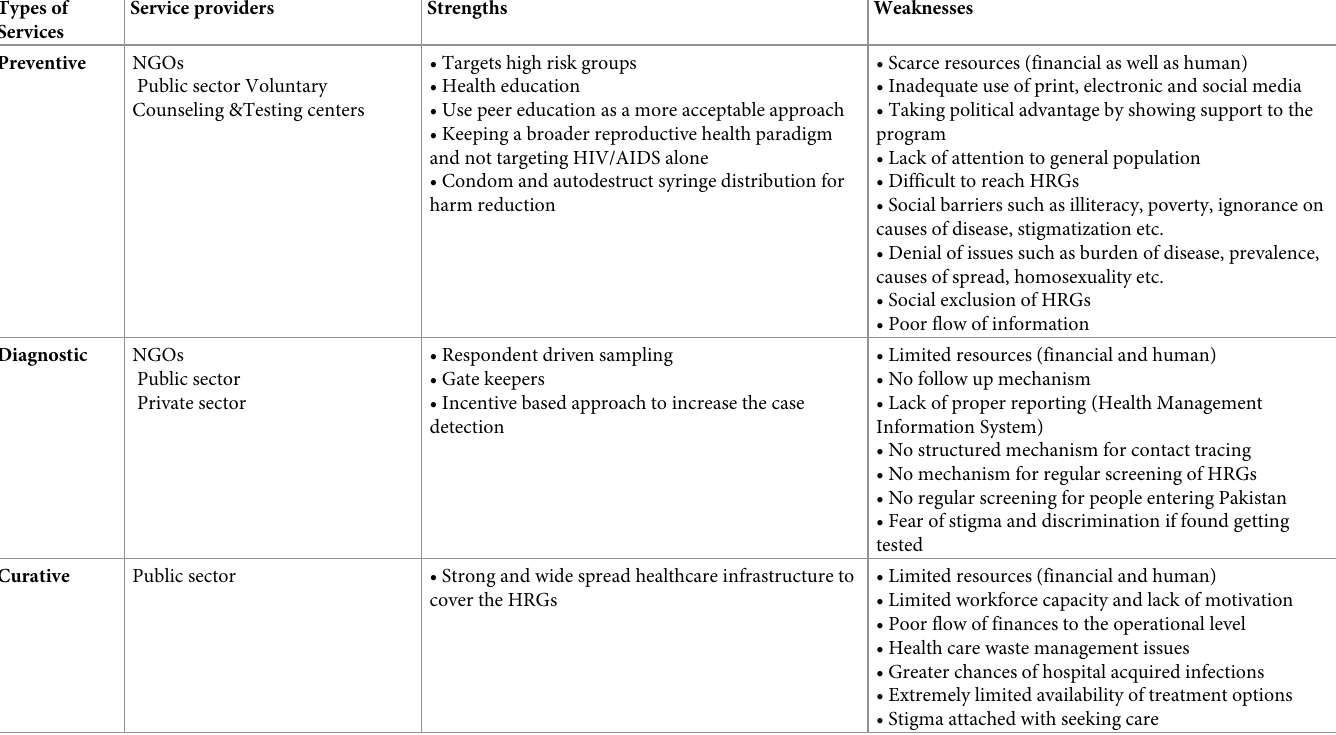
Table 1. Service delivery analysis based on key informant